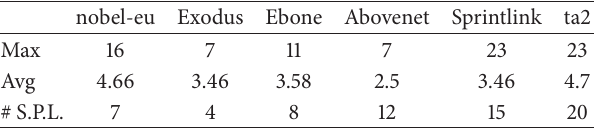
Table 2: Number of line cards per